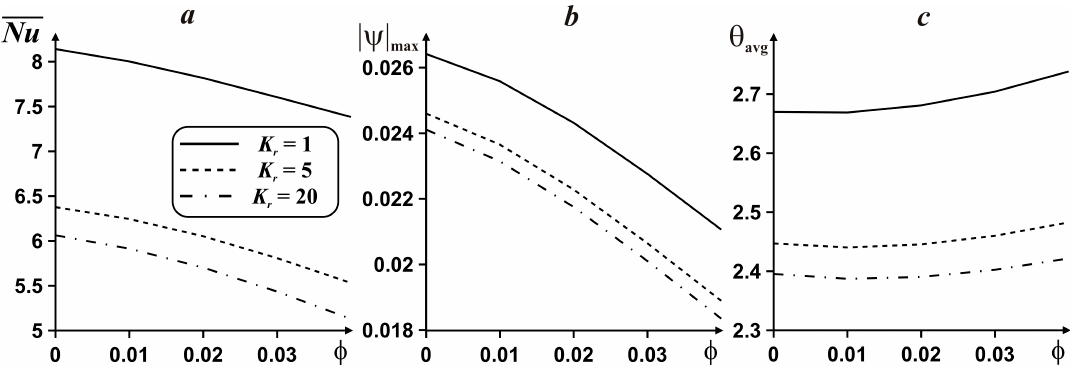
Figure 7. Dependences of the average Nusselt number ( a ), nanoliquid circulation rate ( b ) and mean heater temperature ( c ) on φ and K r for Ra = 10 4 , δ = 0.2.